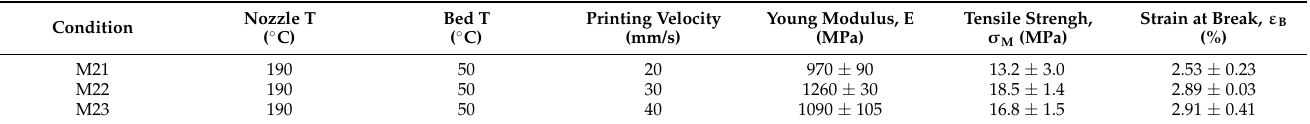
Table 7. Mechanical properties of the 3D pattern printed at different printing velocities.